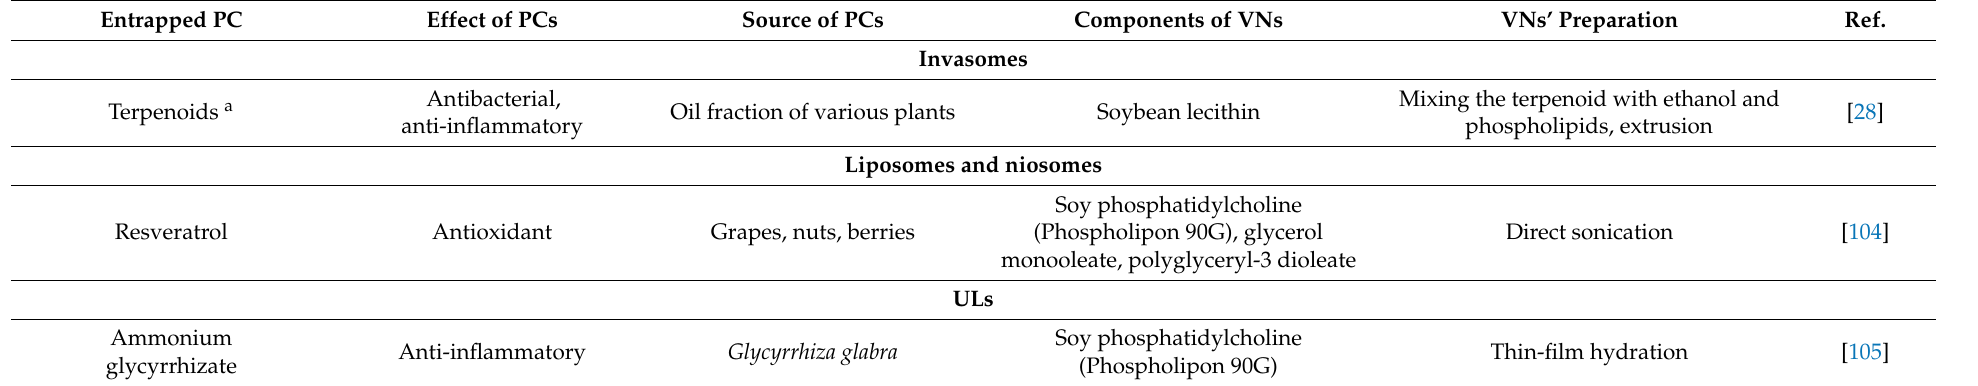
Table 4. Vesicular nanosystems including phytocompounds with potential benefits in the treatment of